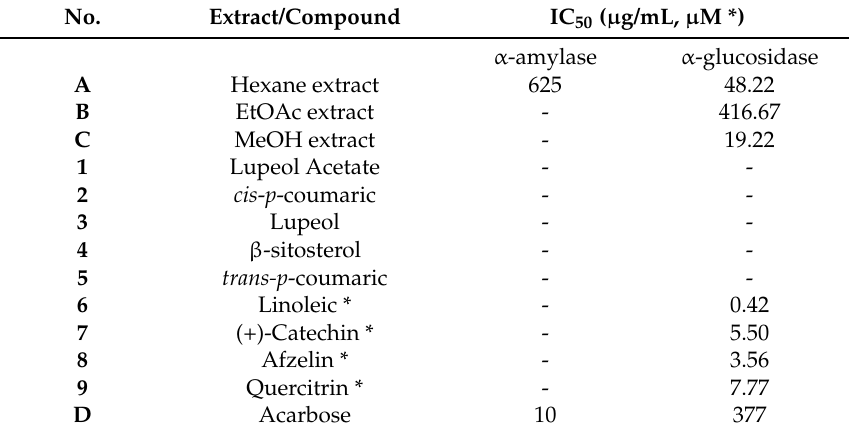
Table 1. In vitro anti α -amylase and α -glucosidase activity (as IC 50 values) of extracts and compounds isolated from Muehlenbeckia tamnifolia